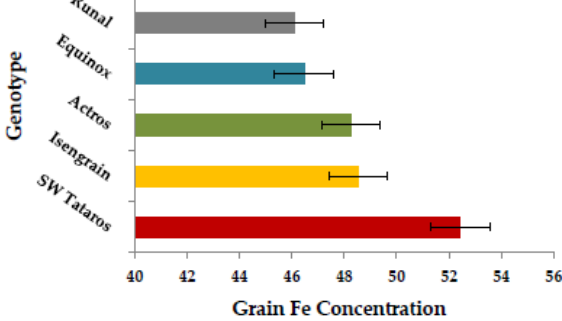
Figure 3. The scale of the top five genotypes with the highest Fe concentration (μg g −1 ) value crossing years years (BLUE).